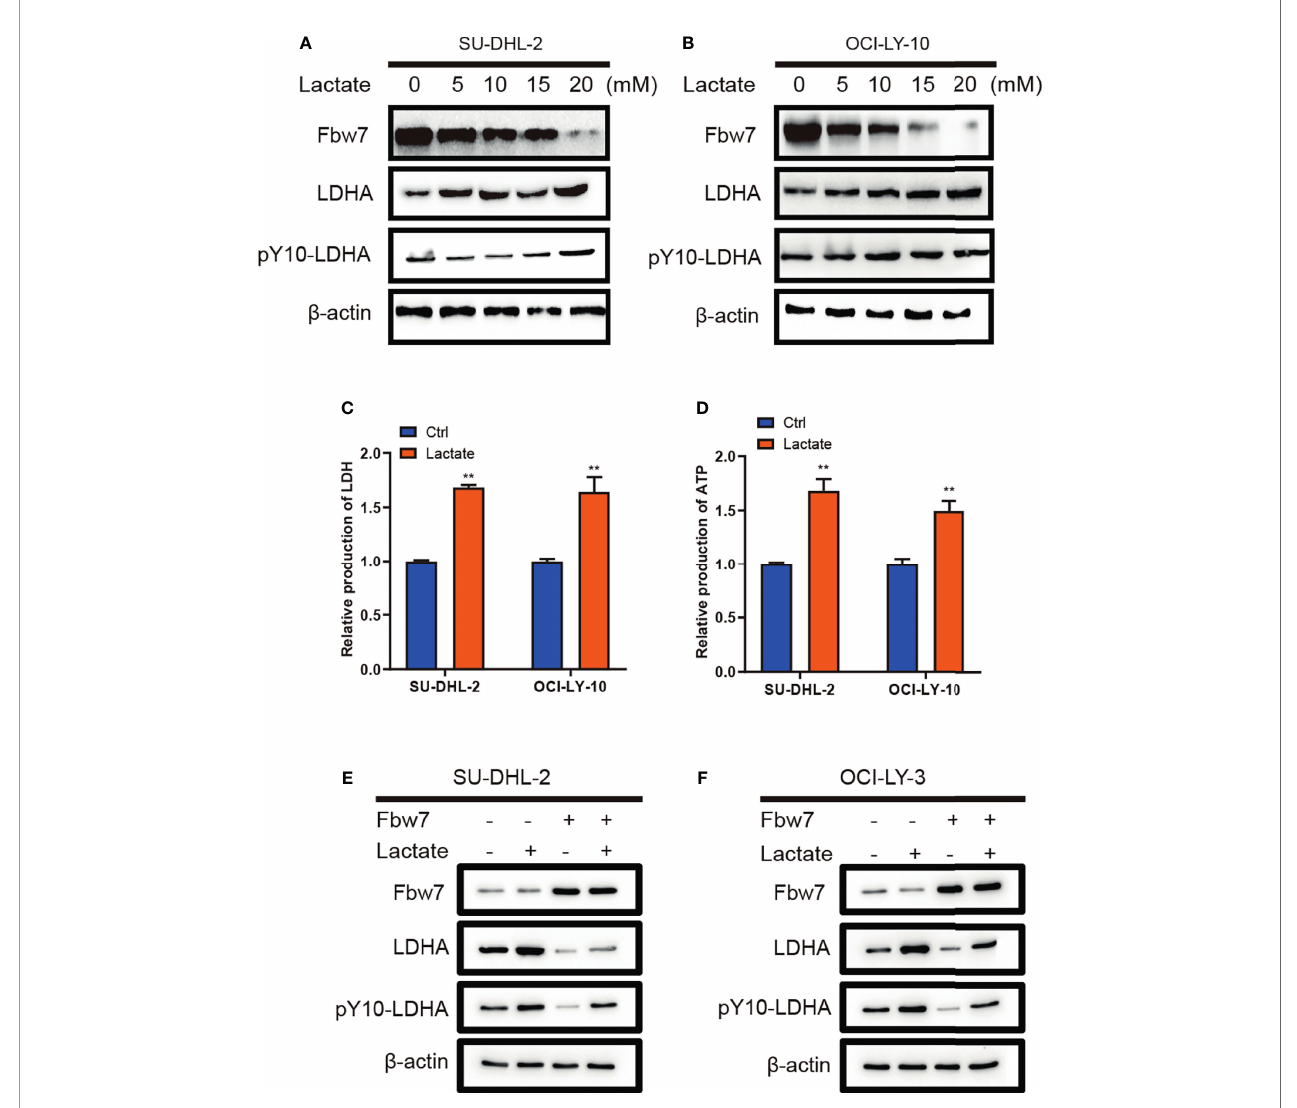
FIGURE 4 | Lactate decreases Fbw7 expression in ABC-DLBCL. (A, B) lactate was added into culture medium of SUDHL-2 and OCI-LY-10 cells in a range of concentrations and Fbw7, LDHA, and pY10-LDHA levels were determined by western blotting analysis. (C) lactate promotes intracellular LDH in SUDHL-2 and OCI- LY-10 cells. The mean ± SD is shown for fi ve independent experiments. **, P <0.01; one-way ANOVA. (D) lactate promotes ATP production SUDHL-2 and OCI-LY- 10 cells. The mean ± SD is shown for fi ve independent experiments. **, P <0.01; one-way ANOVA. (E, F) western blotting shows the expression of LDHA and pY10- LDHA after transfection of Fbw7 and then addition of